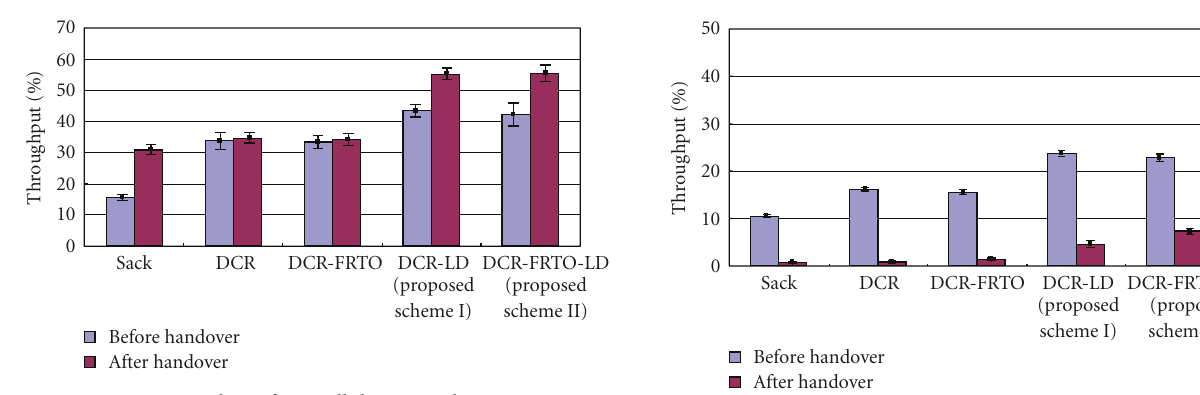
Figure 13: Handover from cellular network to WLAN under